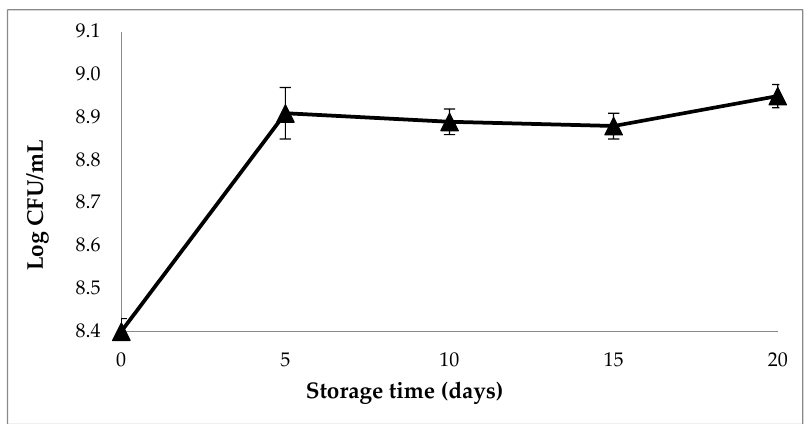
Figure 3. Viability of L. plantarum WCFS1 in SOFB during storage at 4 °C for 20 days.